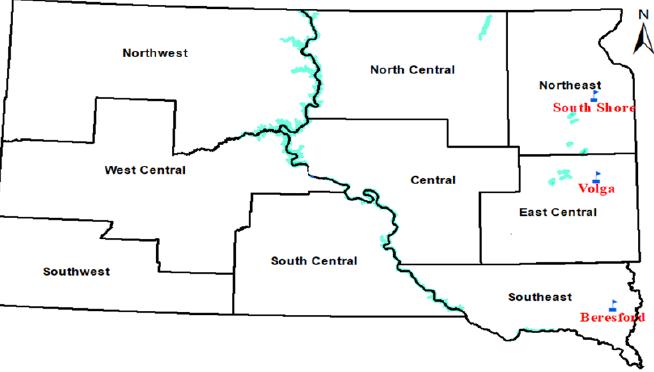
Figure 1. Three different experimental locations (South Shore, Beresford, and Volga) in South Da- kota.